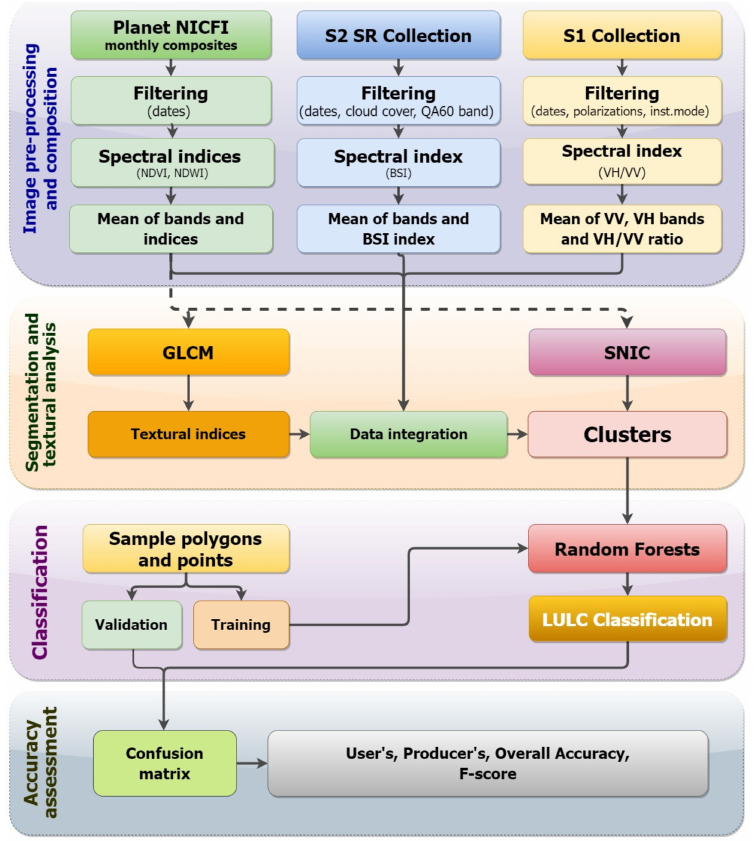
Figure 2. Workflow chart of the